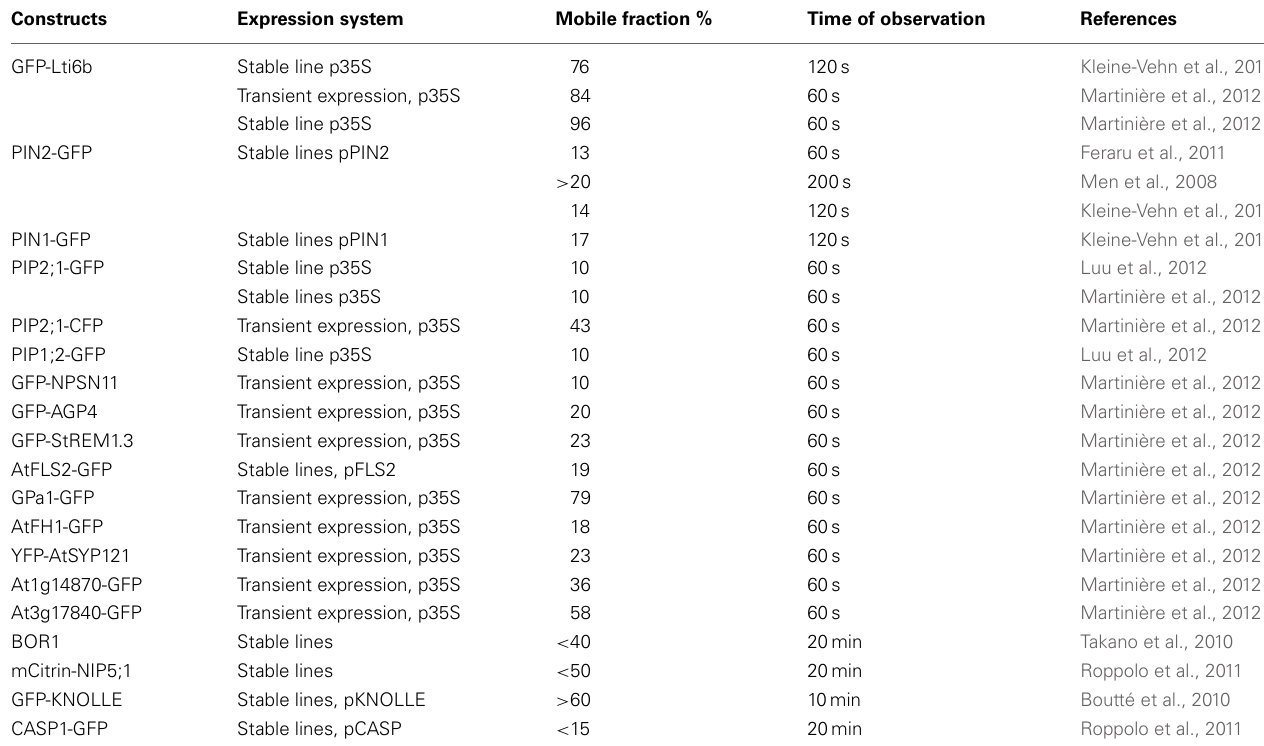
Table 1 | Mobile fraction of proteins evaluated by